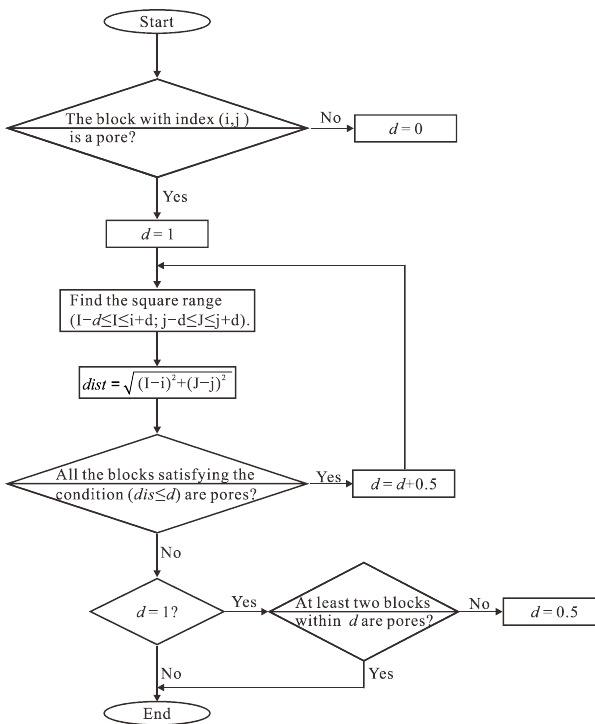
Figure 4. Flowchart of the algorithm for obtaining the distribution of d . Here, d is the distance from a pore block to the nearest grain boundary.